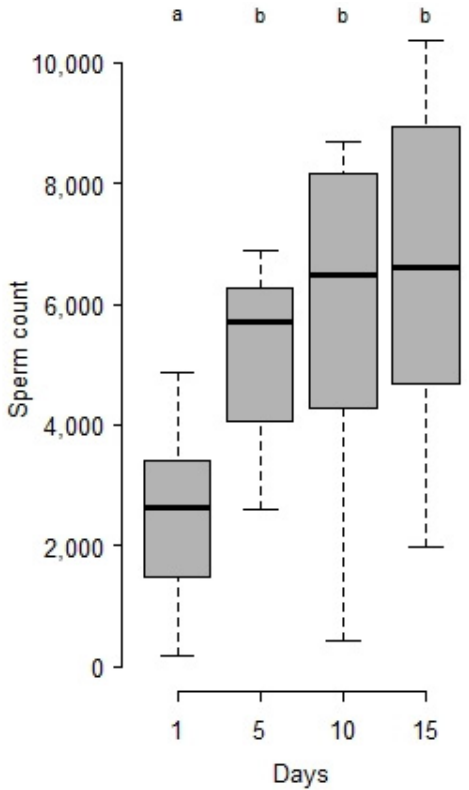
Figure 2. Sperm counted in seminal vesicles of M. rufiventris virgin males during the course of aging at 25 °C. Kruskal–Wallis test, Chi² = 19.8, df = 3, p < 0.001. Letters indicate series that are statistically different from the previous one (Wilcoxon tests, 1 vs. 5 days, W = 12, p < 0.001; 5 vs. 10 days, W = 55, p = 0.36; 10 vs. 15 days, W = 45, p = 0.51).